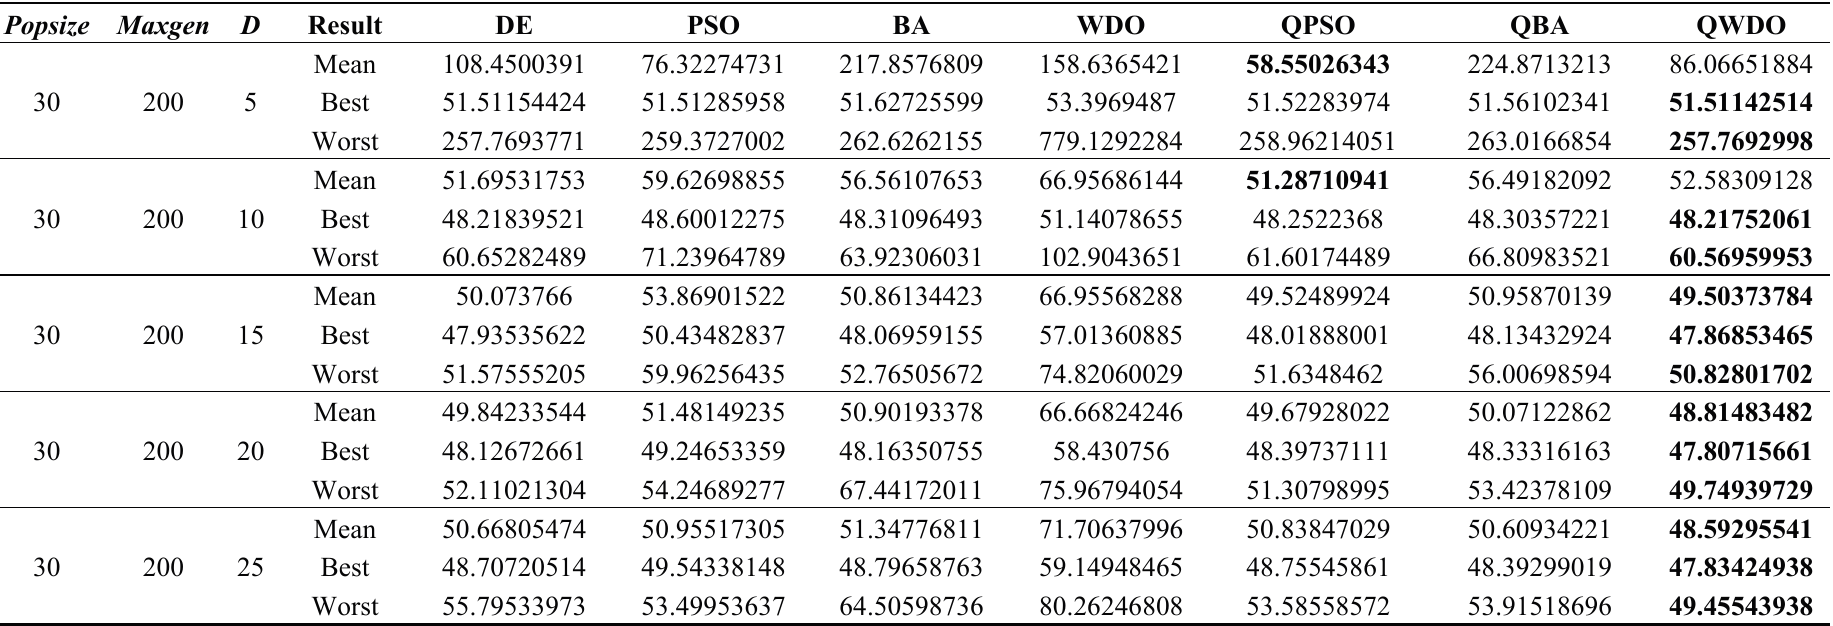
Table 12. Experimental results for the second test instance in different D